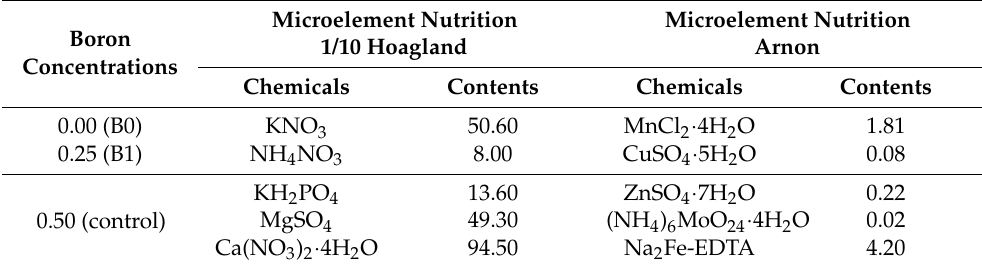
Table 1. The composition of nutrient solution (mg · L − 1 ).